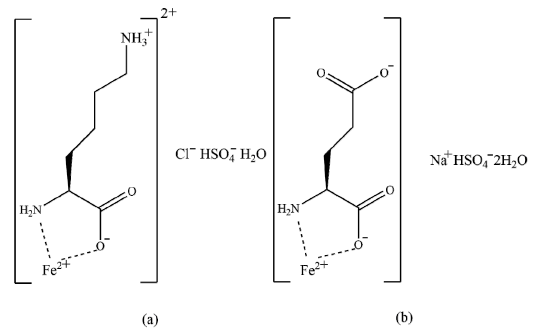
Figure 1. The structure formulas of iron chelates of lysine ( a ) and glutamic acid ( b ). Table 1. Ingredient composition and nutrient level of the basal diets (air-dry